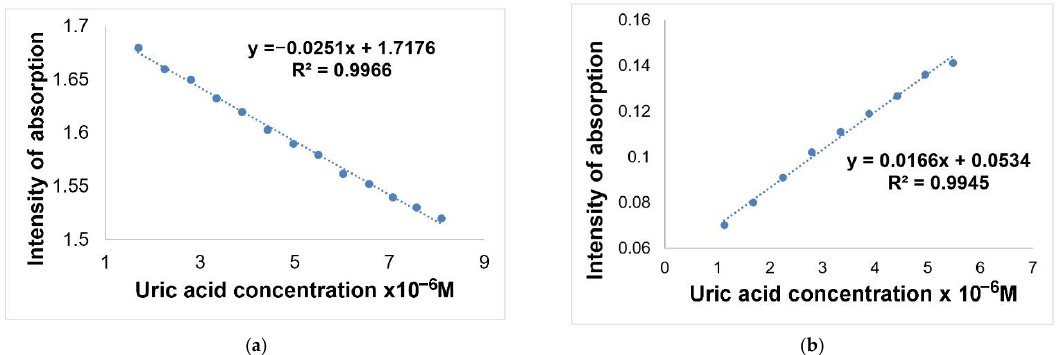
Figure 17. The linear dependence of the absorption intensity of TAmPP-Pt@CuNPs hybrid material measured as function of UA concentration: ( a ) on theSoret band; ( b ) on the QI band.